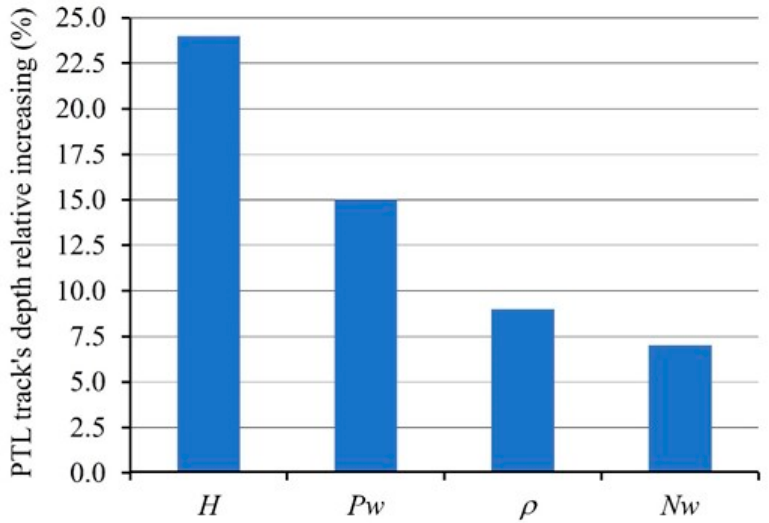
Figure 8. Degree of influence on the PTL track depth of parameters P w , N w , ρ and H when changing their values by 25%.